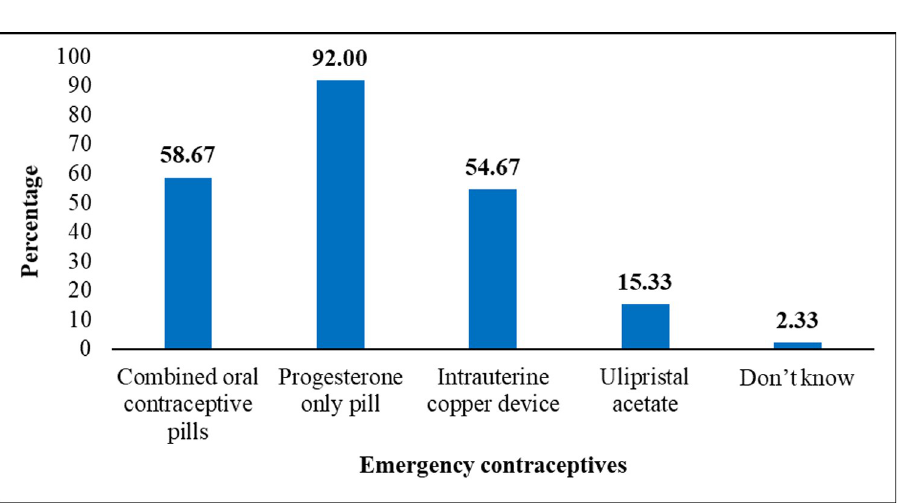
Fig 1. Respondents’ knowledge on the methods of emergency contraception (n = 300).